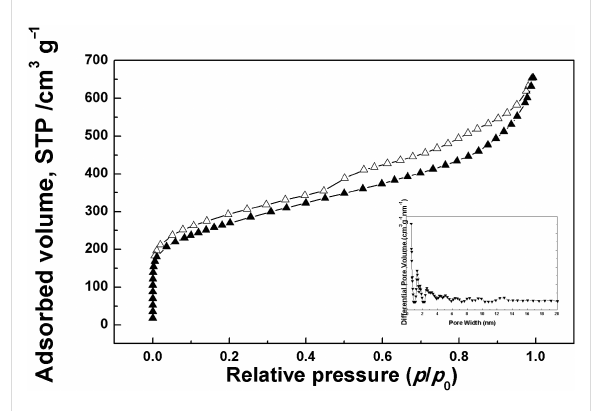
Figure 4: Nitrogen sorption isotherm at 77 K and the pore size distri- bution profile calculated by NLDFT analysis (inset) of the AgNPs / SugPOP-1